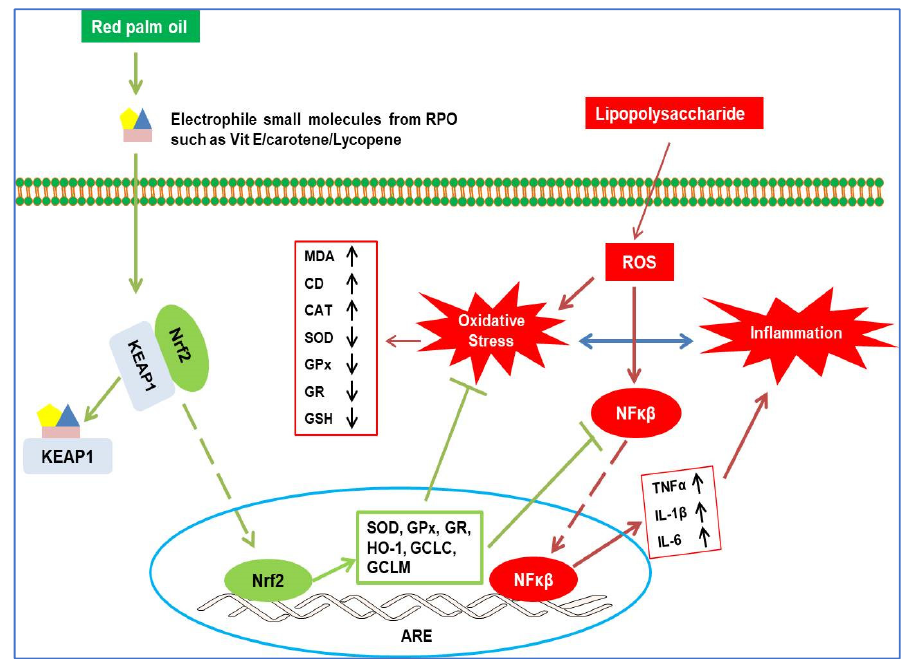
Figure 7. A proposed schematic representation showing the protective mechanism of red palm oil on LPS-induced hepatic injury. ARE, antioxidant response element; CAT, Catalase; CD, conjugated diene; GCLC, glutamate cysteine ligase catalytic subunit; GCLM, glutamate cysteine ligase modulatory subunit; GPx, glutathione peroxidase; GR, glutathione reductase; GSH, reduced glutathione; HO-1, heme oxygenase 1; IL-1 β interleukin 1 β ; IL-6, interleukin 6; Keap1, Kelch-like ECH-associated protein 1; MDA, malondialdehyde; Nrf2, nuclear factor erythroid 2-related factor 2; NF κβ , nuclear factor kappa β ; SOD, superoxide dismutase; TNF α ; tumor necrosis factor α .